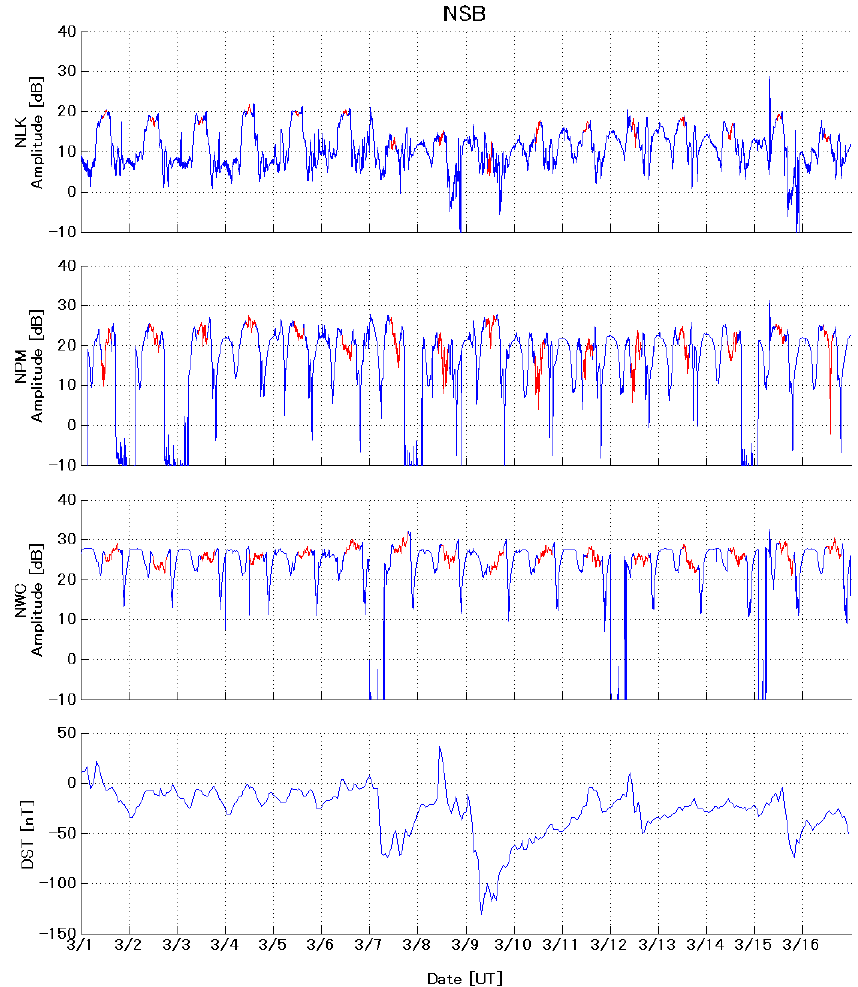
Figure 2. Diurnal patterns of VLF amplitude for high-latitude (NSB-NLK) (top panel), mid-latitude (NSB-NPM) (second panel) and north- south path (NSB-NWC) (third panel) from 1 to 16 March in 2012. Local nighttime periods are shown in red color in the diurnal patterns. The bottom panel shows Dst variations for the relevant time